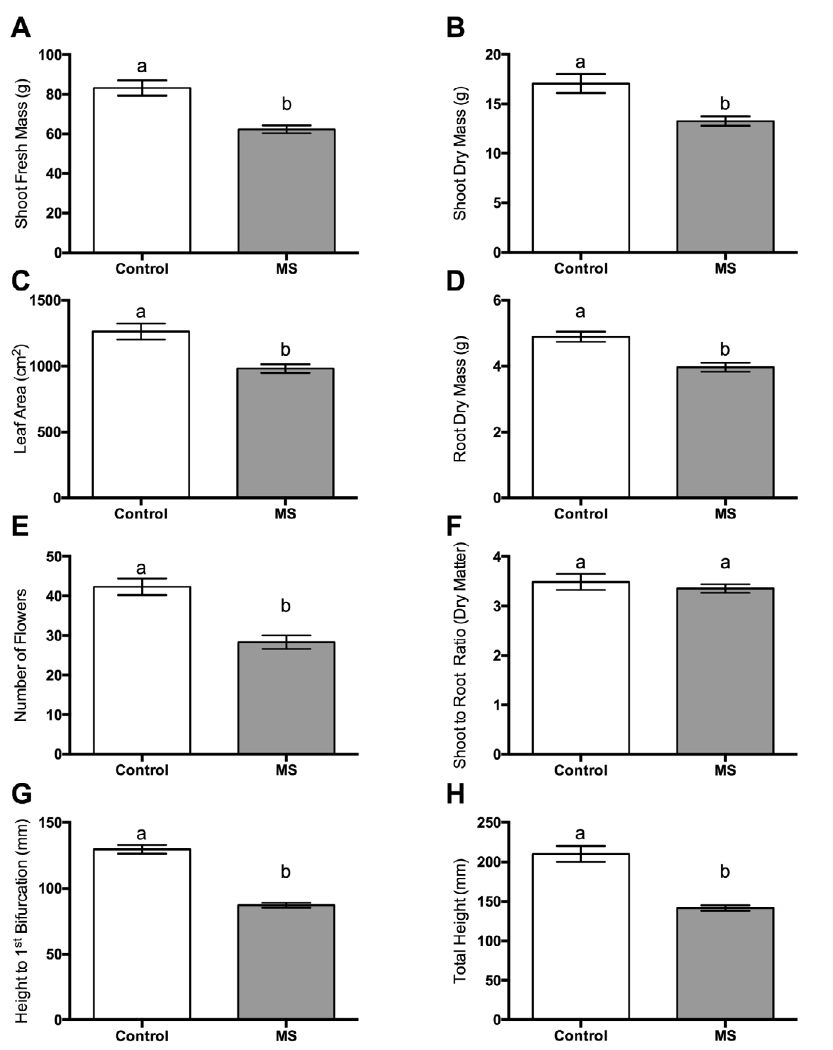
Figure 1: Plant growth response to mechanical stimulation during juvenile and early anthesis growth stages: (A) Shoot fresh mass; (B) Shoot dry mass; (C) Leaf area; (D) Root dry mass; (E) Flower production; (F) Shoot to root dry matter ratio; (G) Height at the first stem bifurcation; (H) Total height. Columns with the same letter appearing above do not differ at p≤0.05. Error bars are SEM.